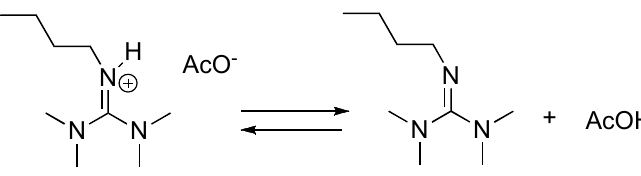
Figure 14. Brønsted guanidine acid-base ionic